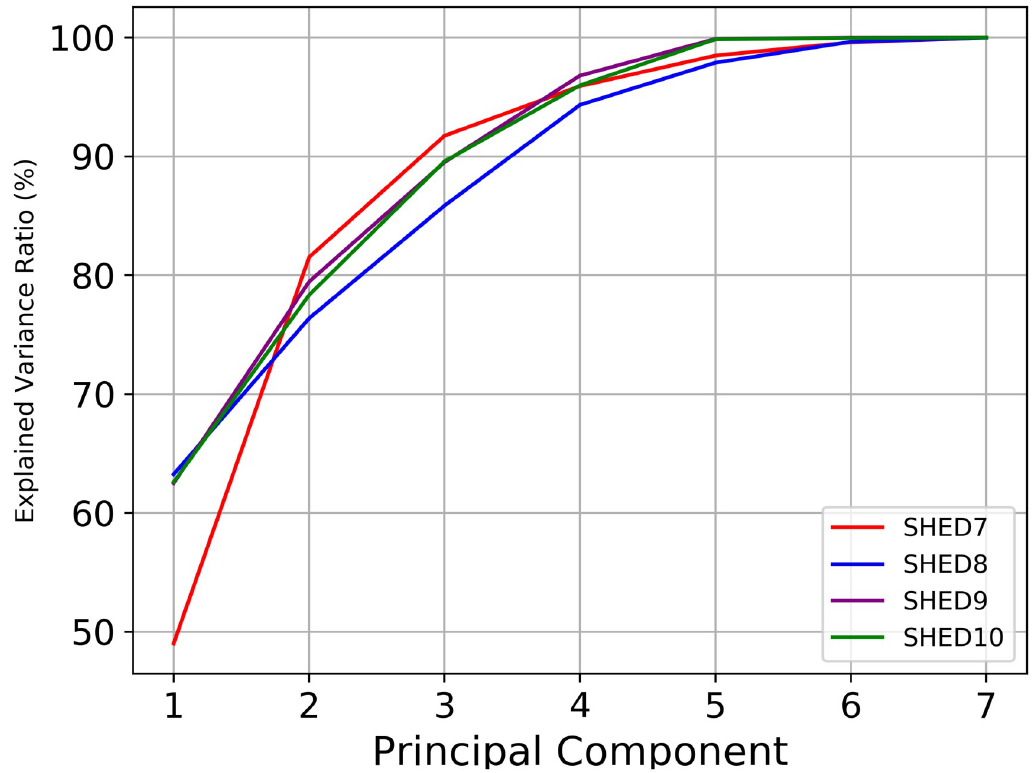
Fig 7. Principal component analysis. PCA result of the cumulative explained variance ratio. This figure indicates the amount of data that can be described from 1 to the maximum of principal components (number of dimensions of the dataset).